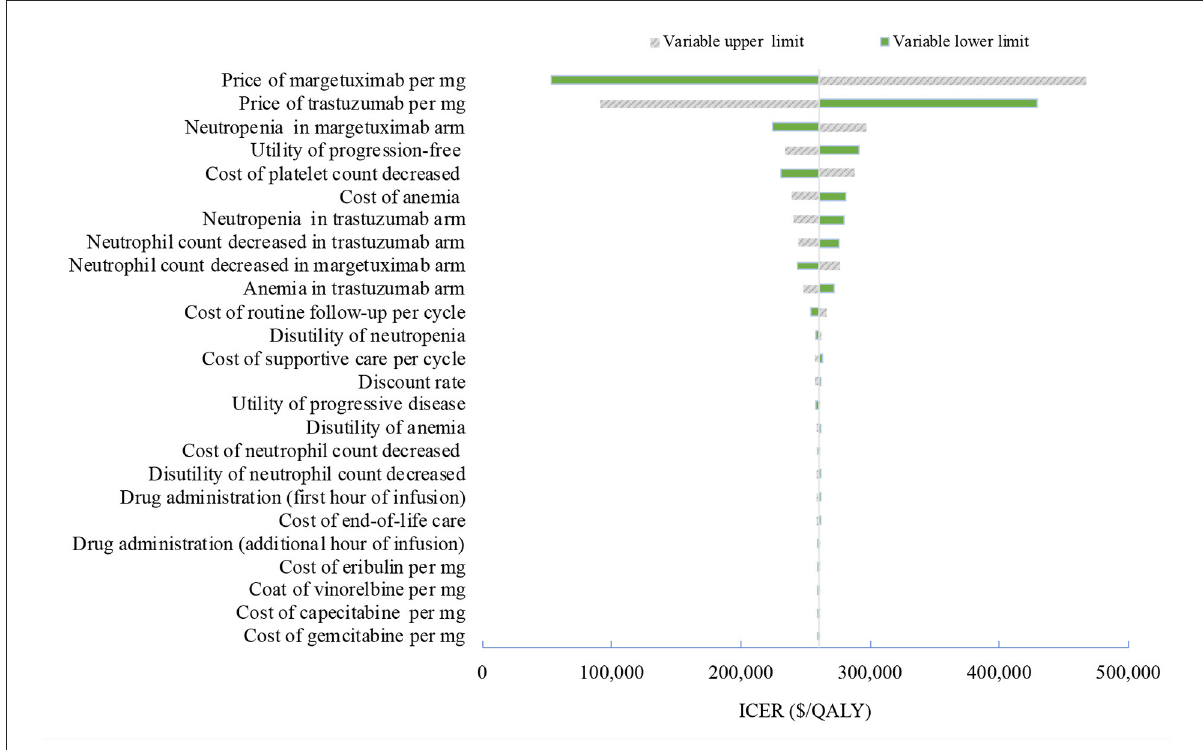
FIGURE1 Tornado diagram of one-way sensitivity analyses of margetuximab vs. trastuzumab in the treatment of pretreated ERBB2-positive advanced breast cancer from the US perspective. QALYs, quality-adjusted